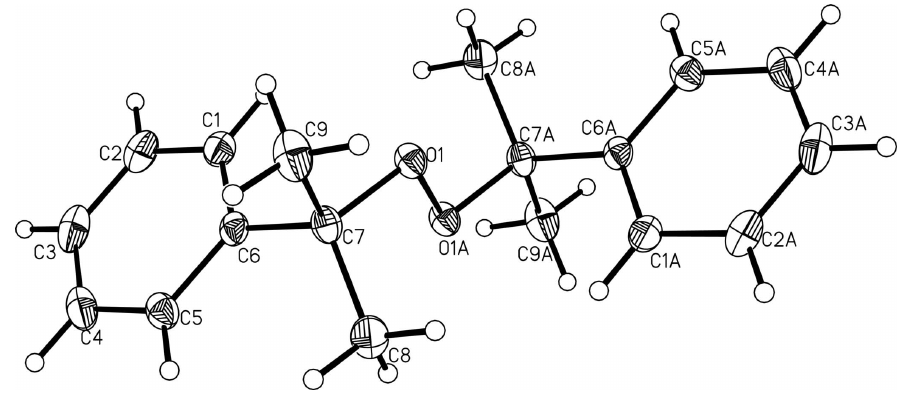
The molecular structure of the title compound, showing the atom-labelling scheme. Displacement ellipsoids are drawn at the 30% probability